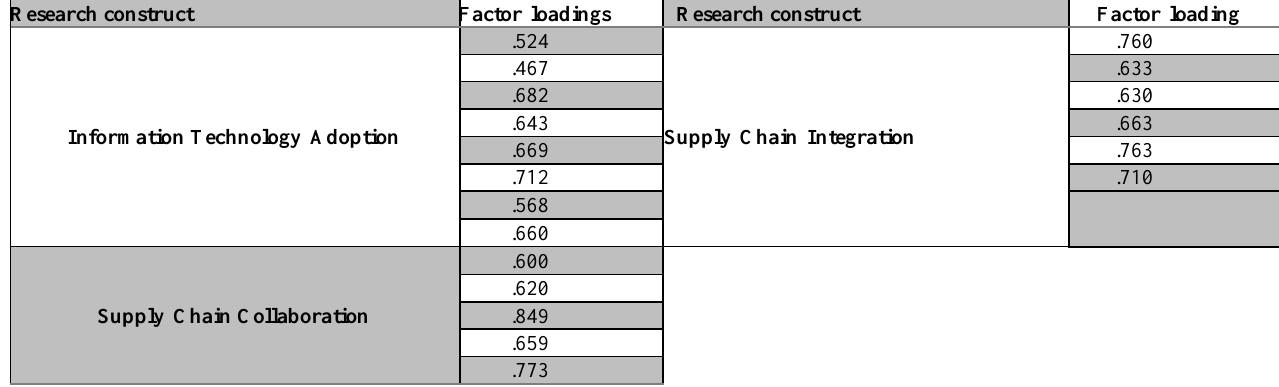
Table 4: Accuracy analysis statistics: Factor loadings Research